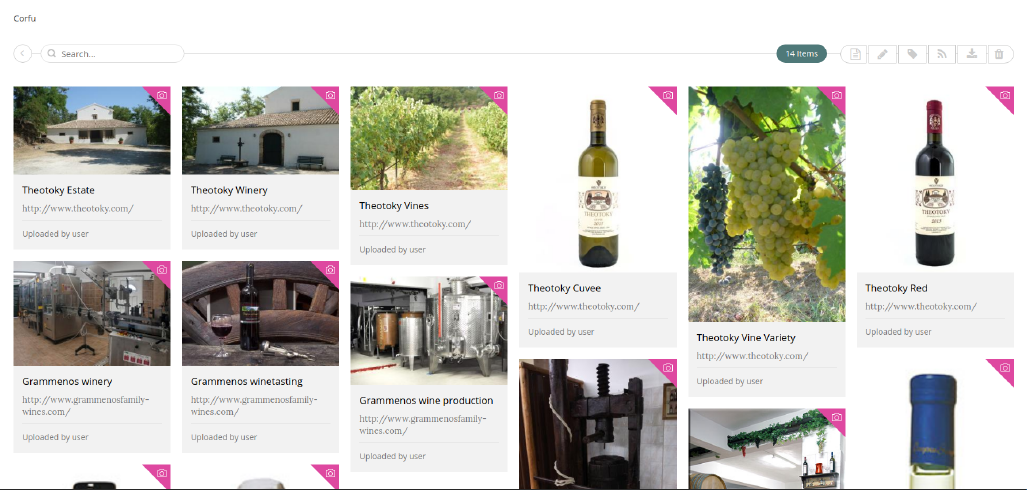
Figure 5. User data collection.